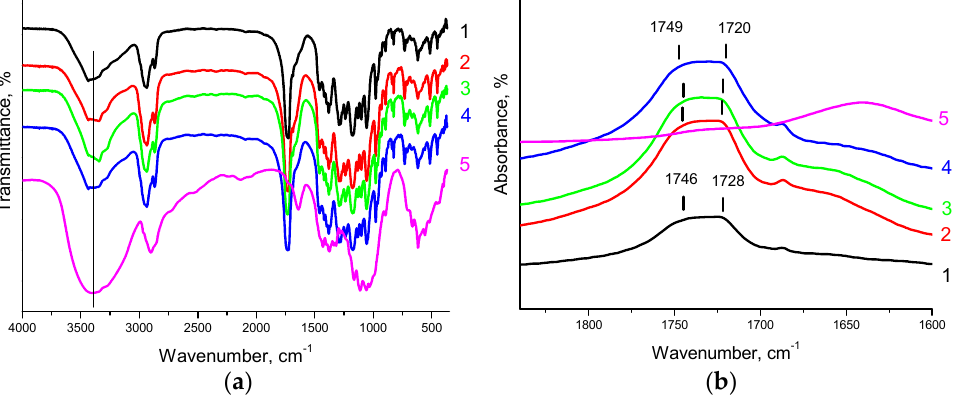
Figure 9. FTIR spectra of the PHBV/PLC(1:1) mixture (1); PHBV/PCL(1:1)/CNC(PVP)–5 (2), PHBV/PCL(1:1)/CNC(PVP)–10 (3), PHBV/PCL(1:1)/CNC(PVP)–15 (4) composites; the neat CNC